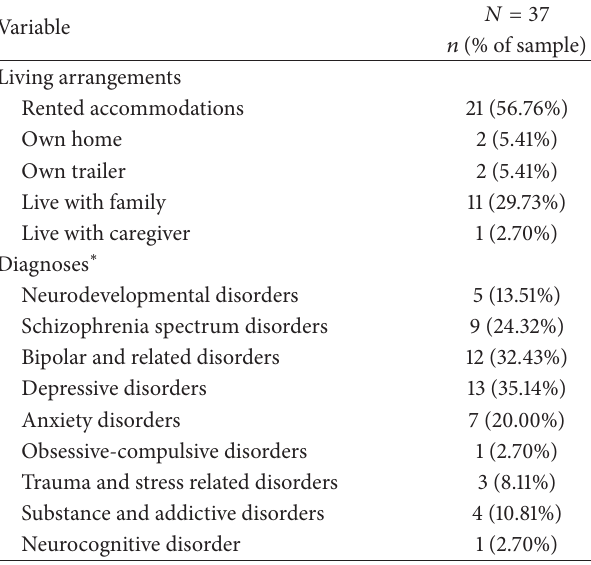
Table 1: Participants’ living arrangements and